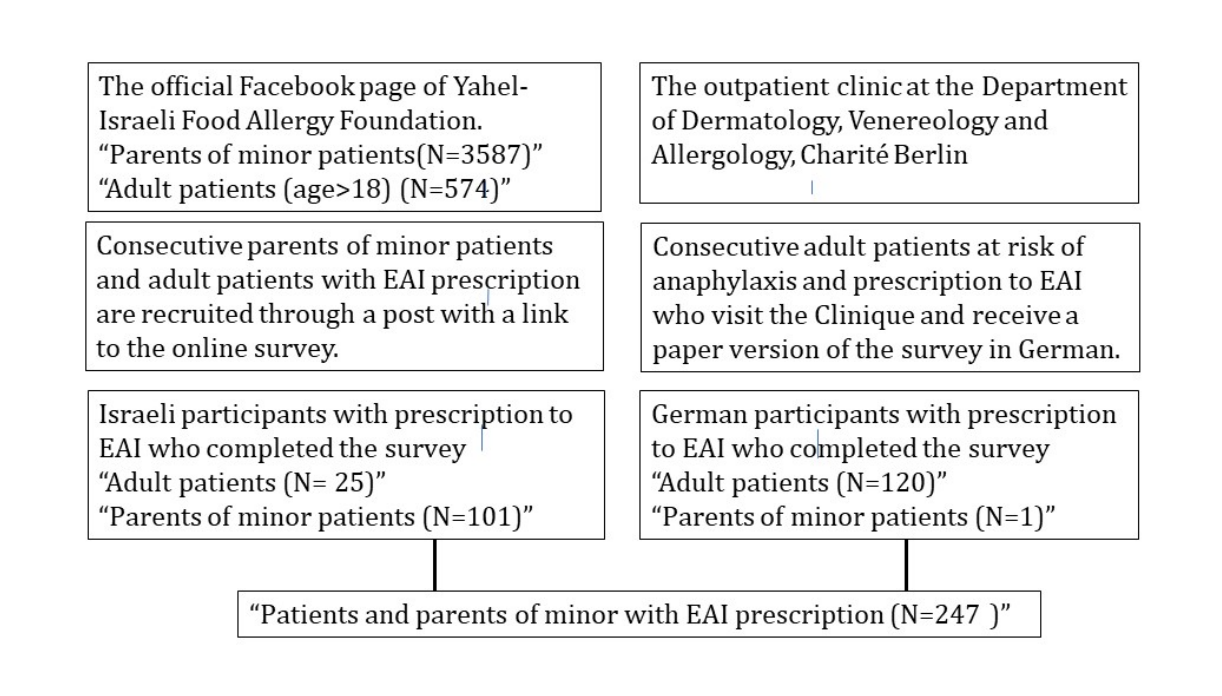
Figure 2. Recruitment process of study participants. EAI: epinephrine auto injector.